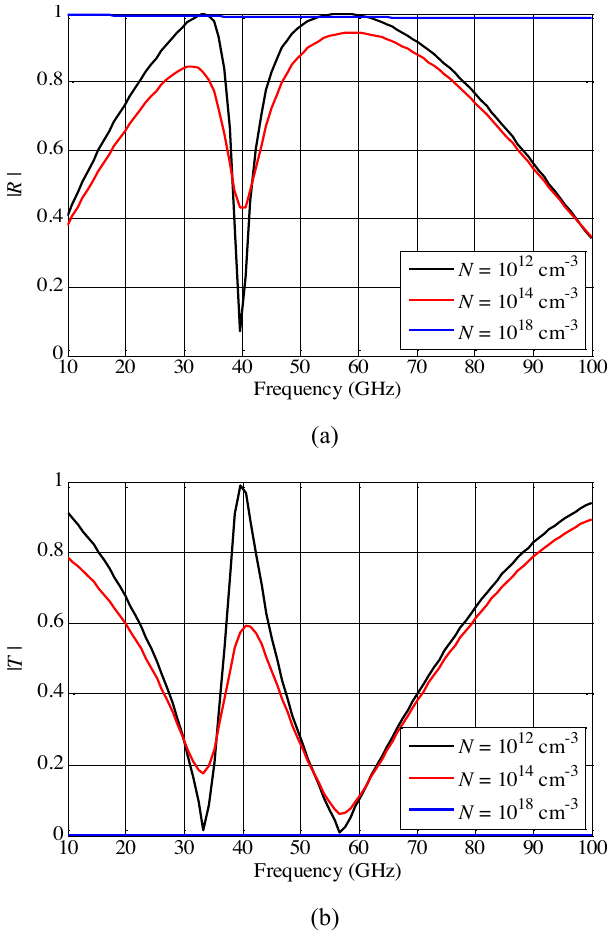
Figure 7. Reflection (a) and transmission (b) spectra of the array placed on an optically activated silicon substrate for different values of the plasma density N .